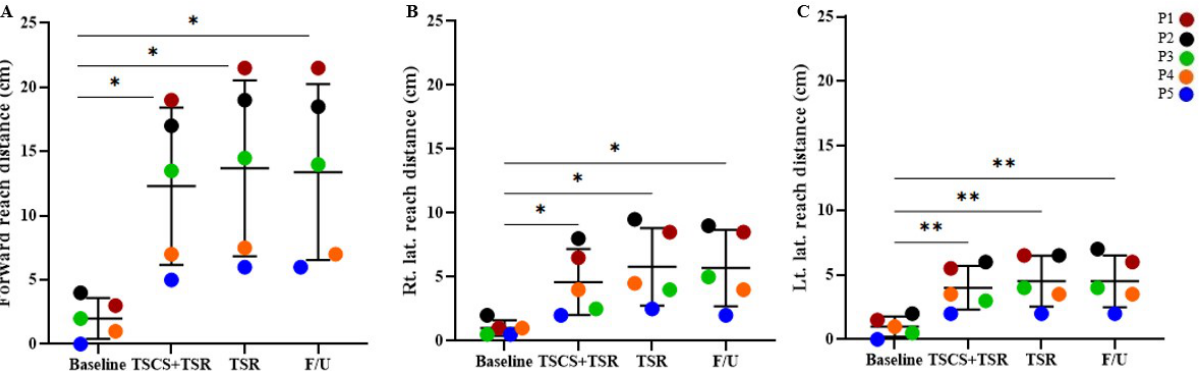
Figure 4. The increased functional scores of mFRT measured from the baseline. Statistical analysis was conducted between the baseline with TSCS+TSR, TSR, and follow-up. ( A ) Forward reach distance, ( B ) right lateral reach distance, and ( C ) left lateral reach distance, respectively, measured for each participant during the study. mFRT, Modified Functional Reach Test; TSCS, transcutaneous electrical spinal cord stimulation; TSR, task-specific rehabilitation; F/U, follow-up; * p < 0.05, ** p < 0.01, all in comparison to the baseline value.